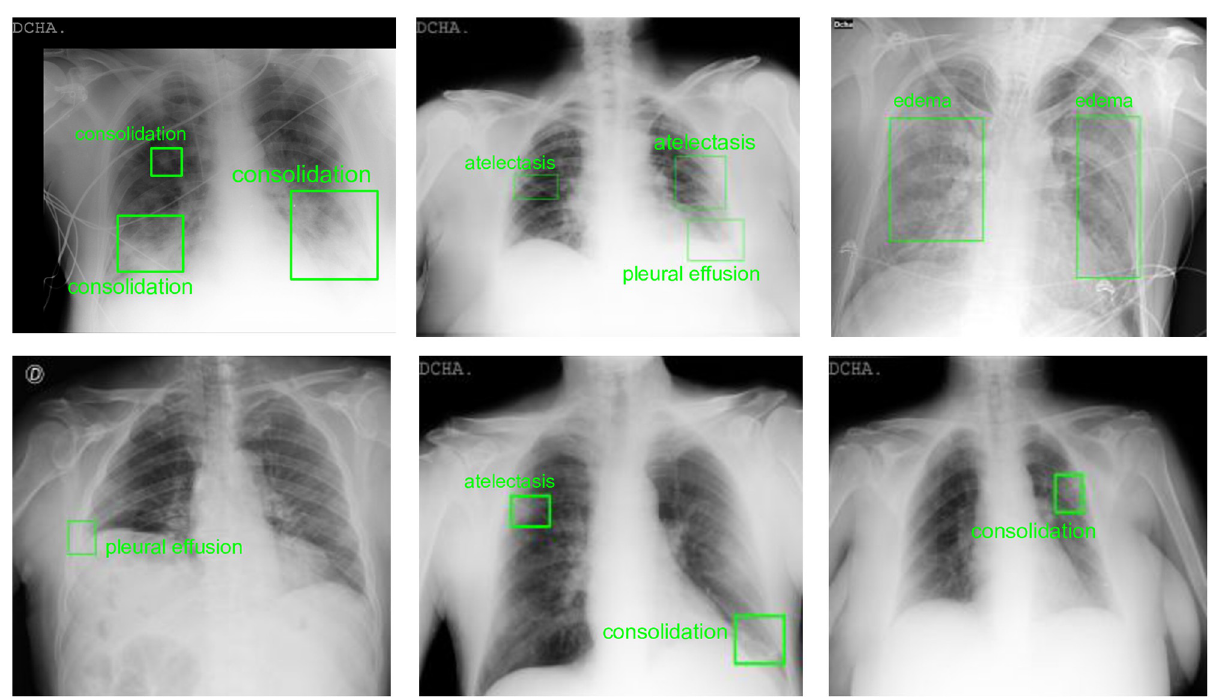
Fig 3. Samples of abnormality annotations performed for BIMCV-COVID19+ dataset. The regions annotated by the radiologists are depicted using green bounding boxes along with the abnormality annotation.